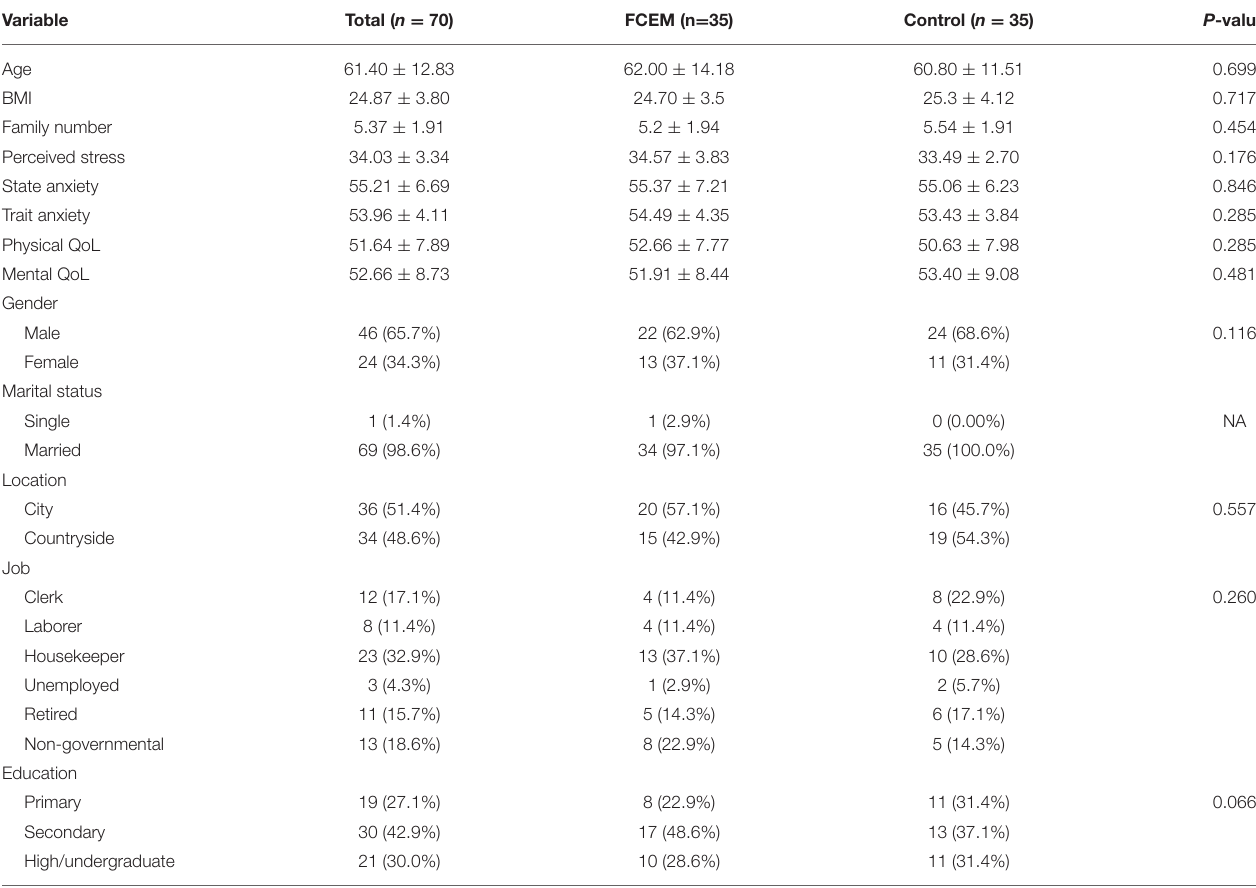
TABLE 1 | Demographics and baseline